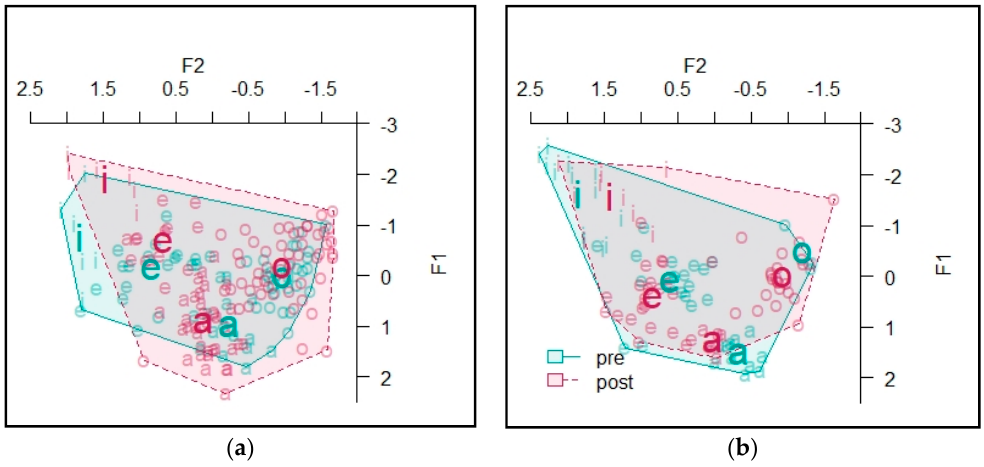
Figure 9. Informant C vowel spaces from pre-semester and post-semester measurements: ( a ) vowels from unstressed syllables; ( b ) vowels from stressed syllables.